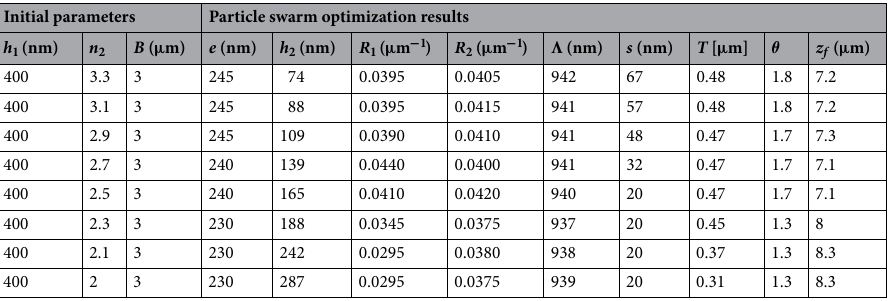
Table 3. Design parameters of the simulated Si x N y –Si 3 N 4 GCs for a 400 nm thick Si 3 N 4 photonic platform with Si x N y and Si 3 N 4 as top layer materials.